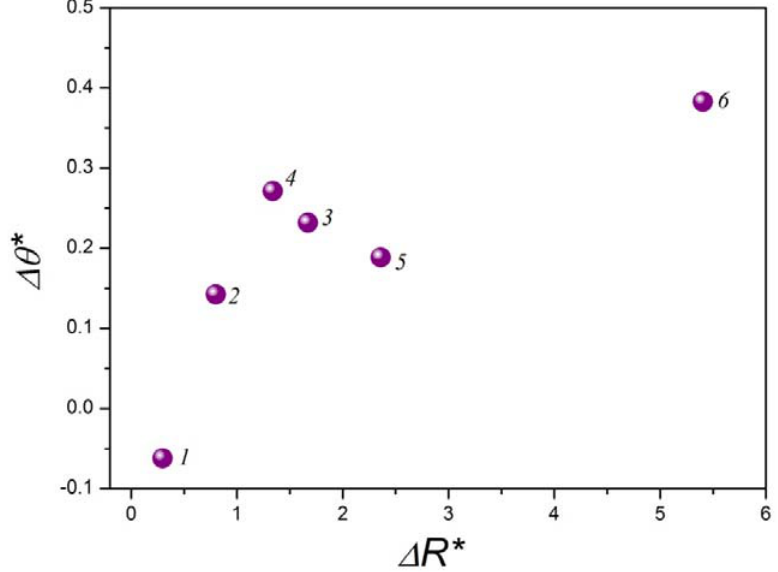
Figure 8. Relationship between topographical anisotropy and contact angle anisotropy using the T-S Model.